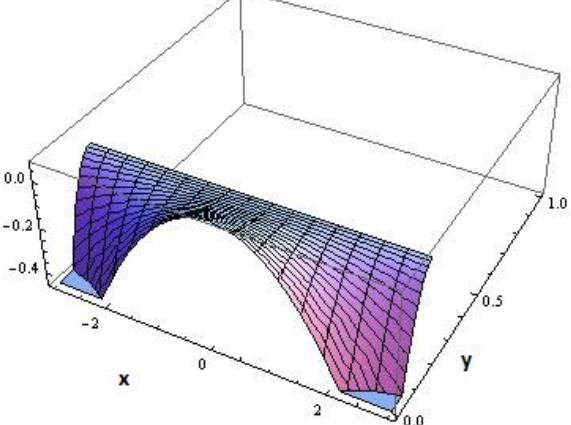
Figure 6. The capacity component F TT of the free energy fluctuations as a function of the vacuum parameter x : = θ and temperature y : = T , describing fluctuations of the YM vacuum ensemble for a given anomaly factor c , decoherence temperature d , and critical exponent e .